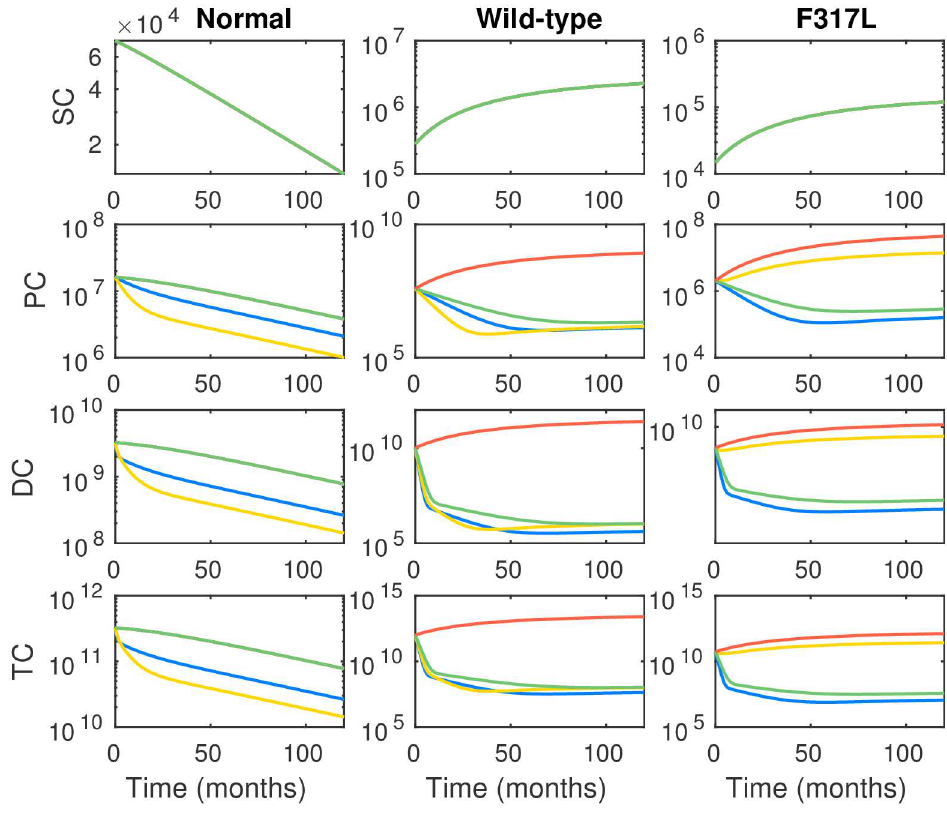
Fig 2. Long term dynamics of healthy, WT leukemic and F317L mutant leukemic cell populations under treatment with standard regimen monotherapy nilotinib (blue), dasatinib (yellow), imatinib (green) and no drug (orange). The unit of vertical axis is number of cells. The dynamics of healthy normal PC, DC and TC with imatinib monotherapy(green) and no drug (orange) coincide,since the birth and death rates of normal PC, DC and TC under imatinib monotherapy happento be the same as the corresponding birth and death rates of normal PC, DC and TC with no drug. Initial conditionsare provided in Table 1 and parameter choices are provided in Section A of S1 Text.